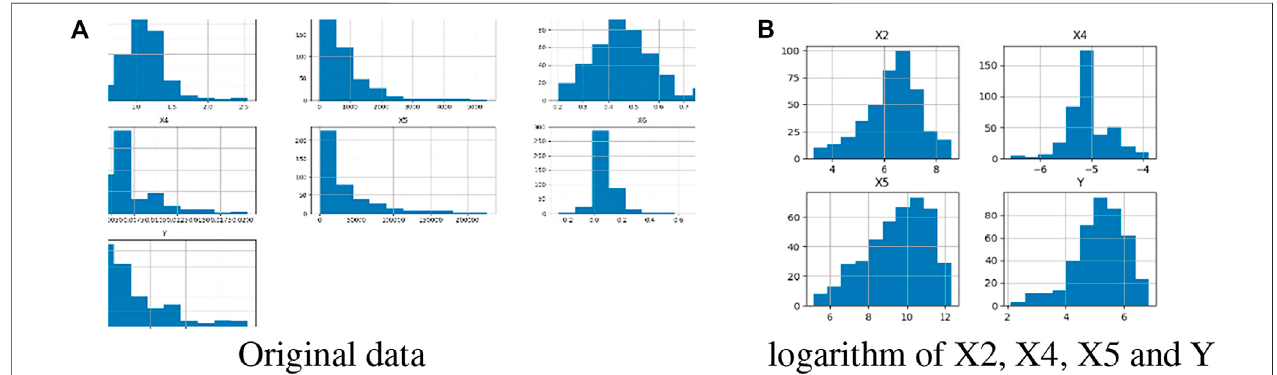
FIGURE 2 | Histogram of data between 2000 and